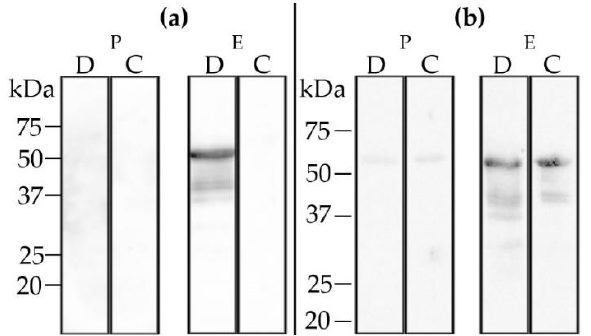
Figure 9. Western blot analysis with recombinant DUGV (D) and CCHFV (C) N protein: Post- immunization sera (E) of the immunized calf (DUGV-IMMU-calf-1) ( a ) and the immunized sheep (DUGV-IMMU-sheep-1) ( b ) strongly react with the DUGV N protein. The sheep serum cross-reacts with the CCHFV N protein, whereas the calf serum reacts specifically with the DUGV N protein only. Sera prior to immunization (P) did not test positive.